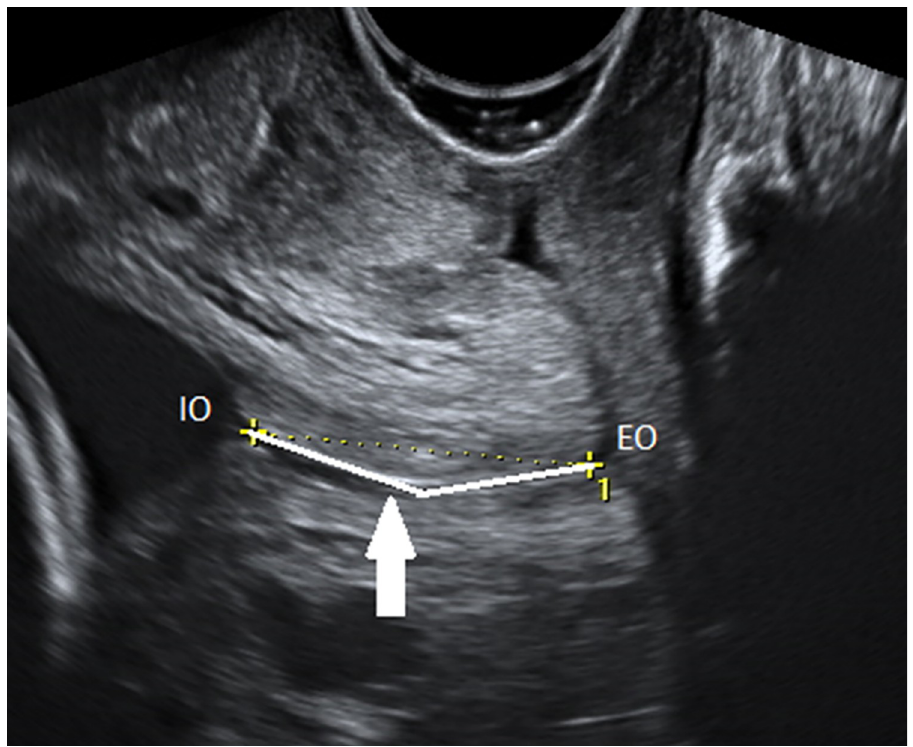
Fig 2. CL measurement curve line technique. Transvaginal ultrasonography in sagittal section. The endocervical mucosa (arrow) is used as a guide to identify the internal (IO) and external (EO) os. The curve technique is presented (continue line): two lines are drawn respecting the curvature of the endocervical canal.